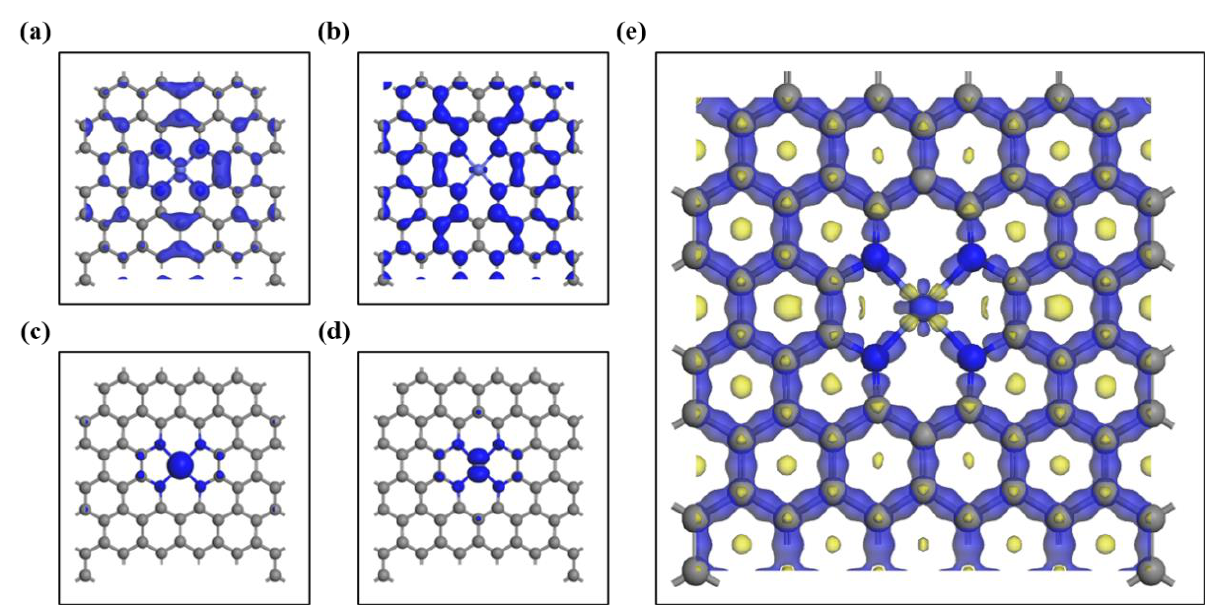
Figure 7. Schematic illustration of ( a ) the top of the valence band and ( b ) the bottom of the conduction band for spin-up electrons. Schematic illustration of ( c ) the top of the valence band and ( d ) the bottom of the conduction band for spin-down electrons. ( e ) Illustration of the electron density difference iso-surface for Co-N-C (blue region represents the accumulation of electrons and the yellow region represents the depletion of electrons).